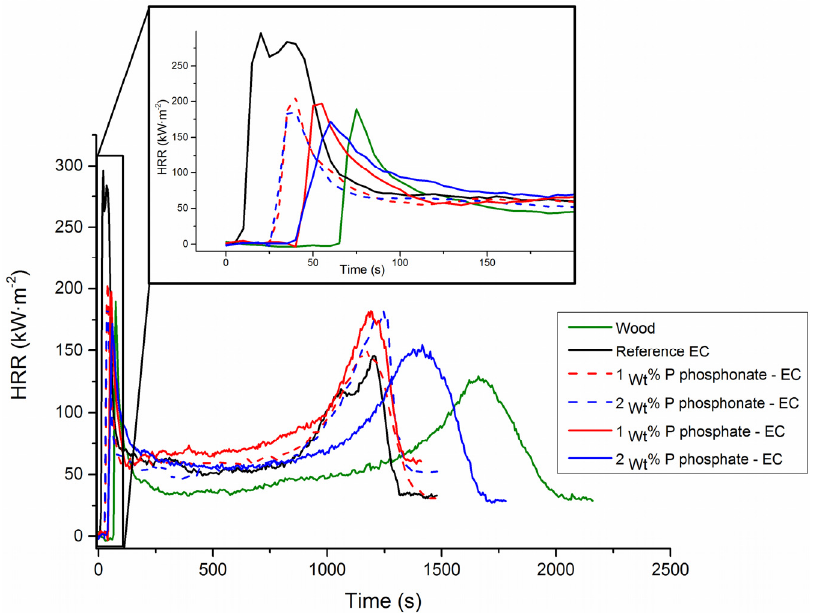
Figure 6. Cone calorimeter curves of reference EC alkyd resin and POxCR diluent EC alkyd resins. Table 5. Results of cone analyses of reference EC alkyd resin and POxCR diluent EC alkyd resins.